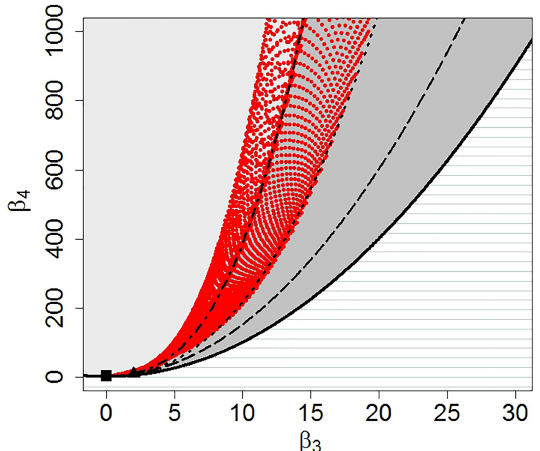
Figure 2. ( β 3 , β 4 ) domain of some families of distributions includ- ing normal (square), exponential (triangle), gamma (dashed line), lognormal (dotted-dashed line), Johnson SB (medium grey area) and Johnson SU (light grey area), and a mixture of two lognormals (red dotted area).